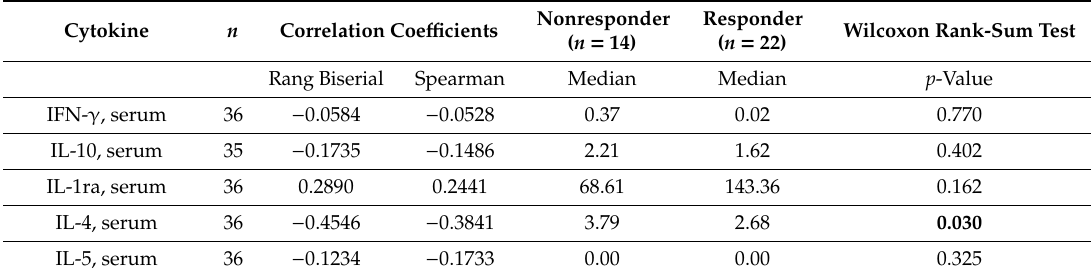
Table 1. Nonparametric comparisons of the serum cytokine distributions in responders versus nonresponders and correlation coe ffi cients between serum cytokine levels and the tumor-associated antigen (TA)-specific